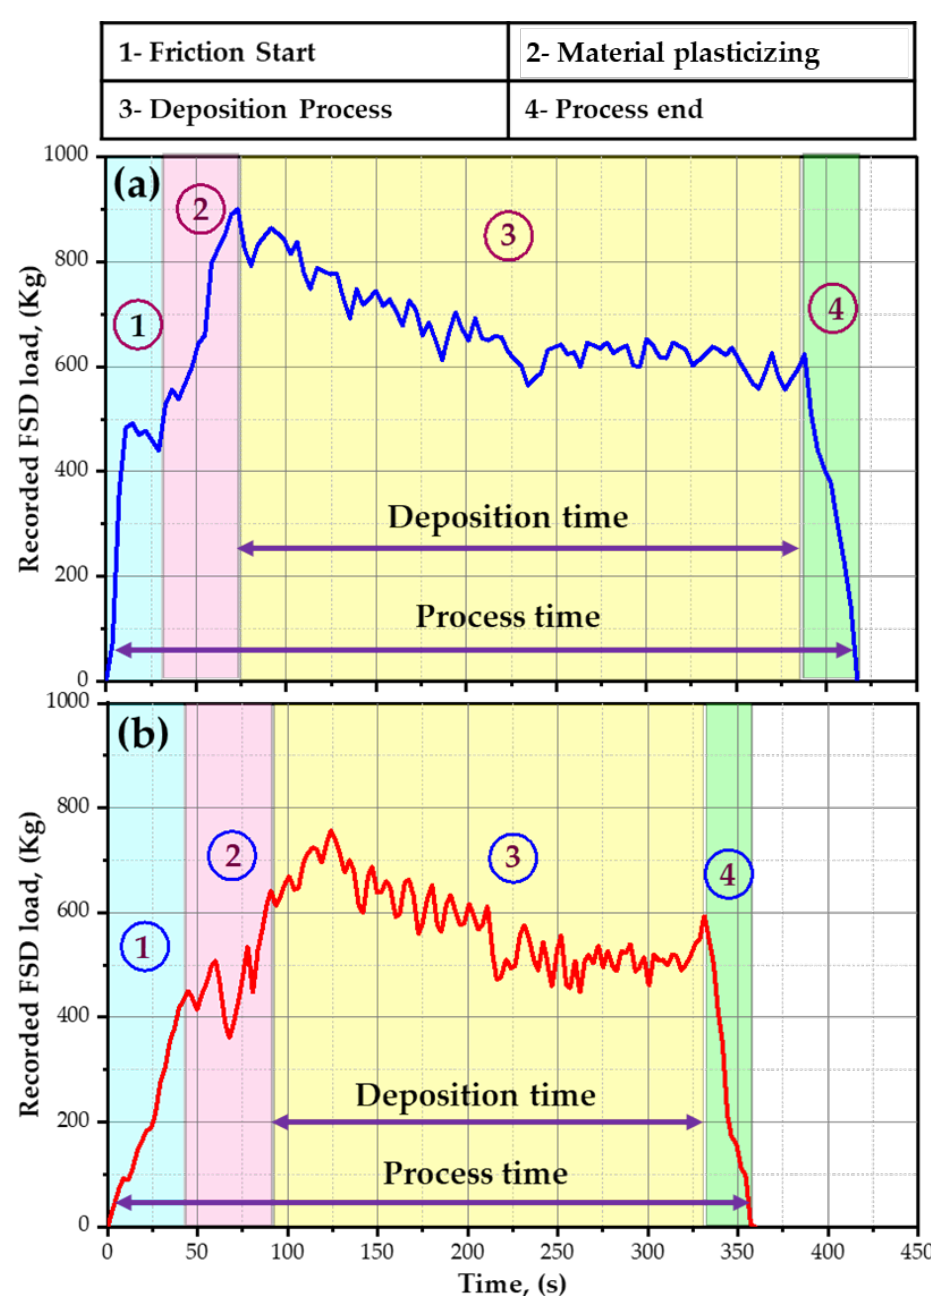
Figure 7. Illustrates the different stages and the recorded machine load during the FSD process to produce the AA2011/nano Al 2 O 3 composites with the ( a ) AA2011-T6 matrix and ( b ) AA2011-O ma-